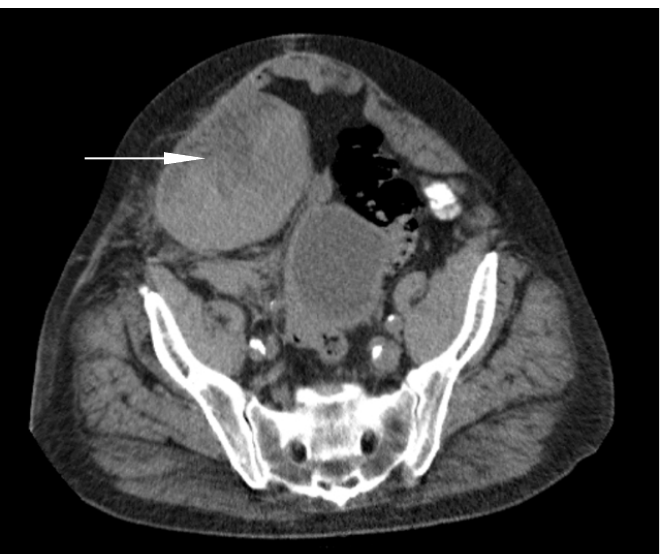
Figure 2. Coronal view computed tomographic scan revealing hematoma within the rectus sheath